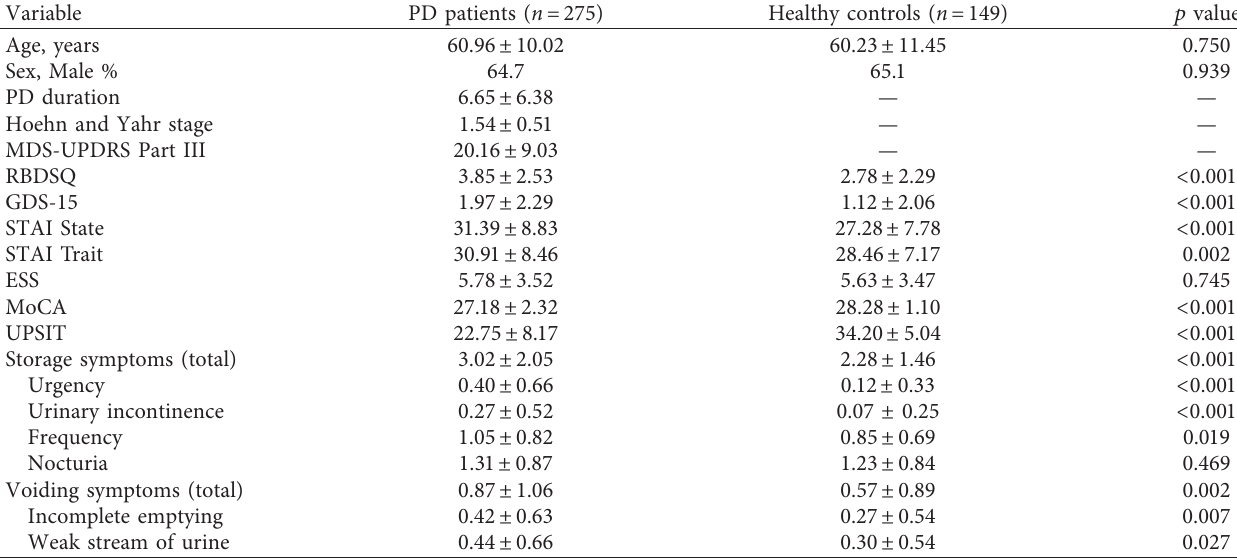
Table 1: Demographic and clinical characteristics of the study